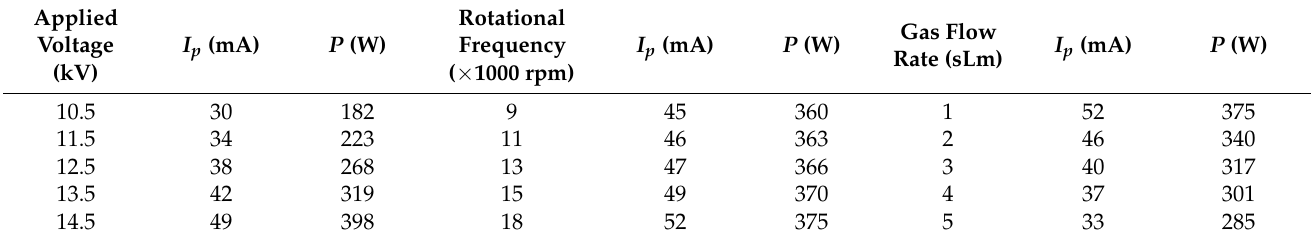
Table 1. Dependence of the averaged consumed power, P , and the peak current on the voltage applied (stationary power electrode and 1 sLm), the rotational frequency (at 14 kV and 1 sLm), and the gas flow rate (at 14 kV and 18,000 rpm).